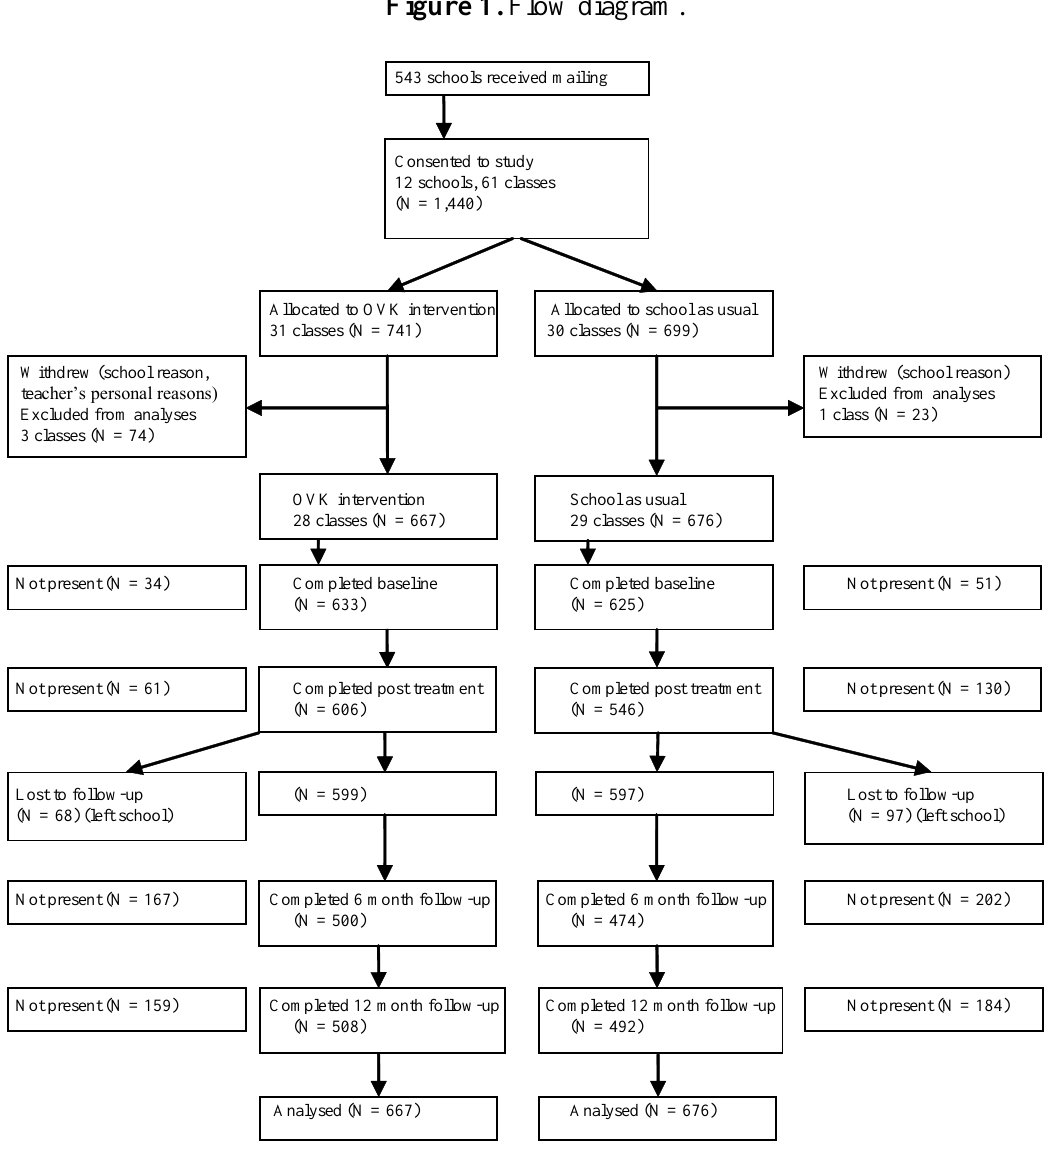
Figure 1. Flow diagram.